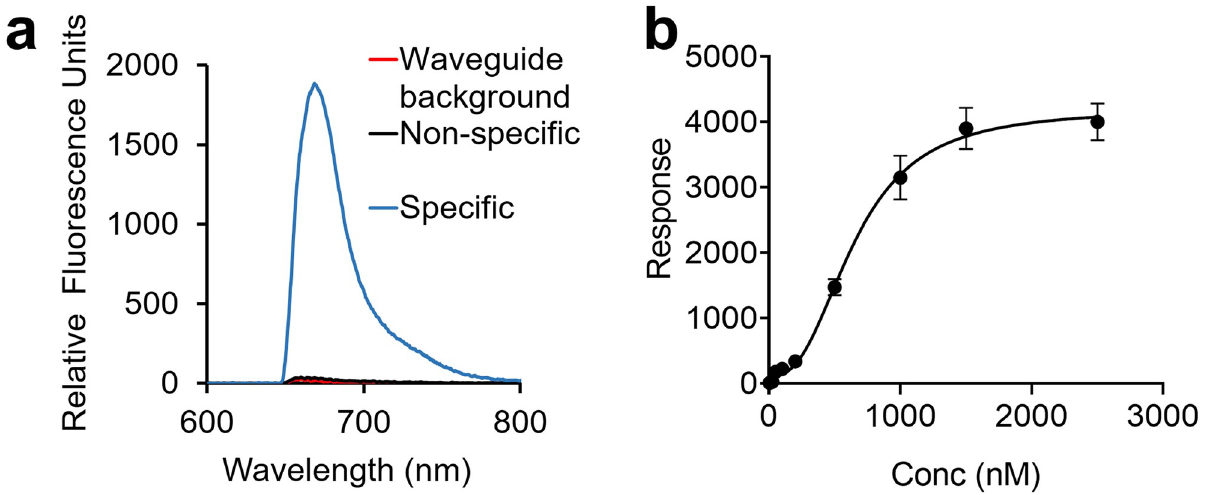
Fig 3. Assay optimization for the detection of LAM in human serum by membrane insertion assay. Measurement of LAM by membrane insertion assay, as a function of concentration. (a) Representative spectral measurement of LAM (0.5 μ M) incubated overnight at 4 ˚C in control human serum, with the specific signal (relative fluorescence units, RFU) from detection of α -LAM antibody (15 nM) as a function of emission wavelength (nm). The background and non-specific signals are measured before the addition of LAM. (b) Membrane insertion assay was performed for the detection of LAM spiked into control serum at various concentrations and incubated overnight to allow incorporation of the amphiphile into carrier assemblies. Sample processing was done to remove lipoproteins. Results are plotted as RFU as measured on the waveguide-based optical biosensor, at increasing concentrations of LAM. All values given in (b) are the mean ± standard deviation derived from at least two independent determinations (n = 2). Statistical significance was determined by Welch’s t-test using GraphPad Prism 8.